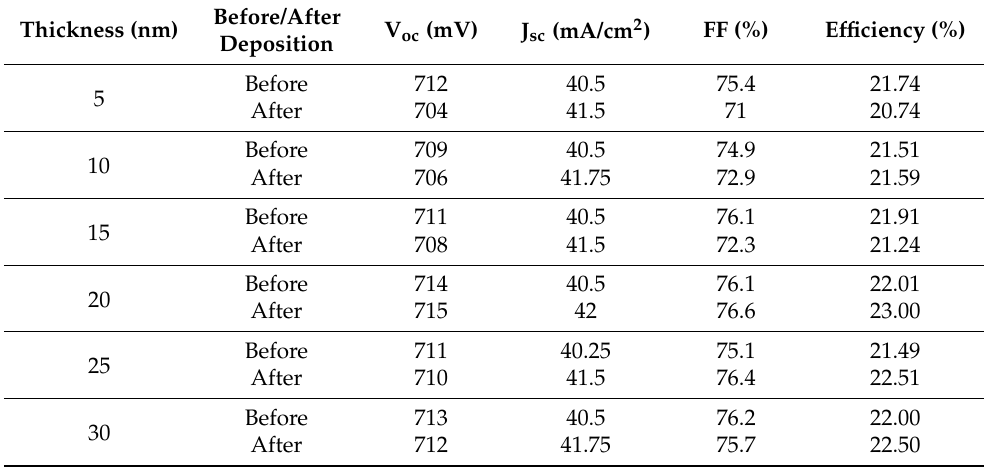
Figure 6. EQE of SHJ solar cell with Al 2 O 3 of ( a ) 5, ( b ) 10, ( c ) 15, ( d ) 20, ( e ) 25, and ( f ) 30 nm. EQE measured before Al 2 O 3 deposition is also shown. Table 1. Results of solar simulator before and after Al 2 O 3